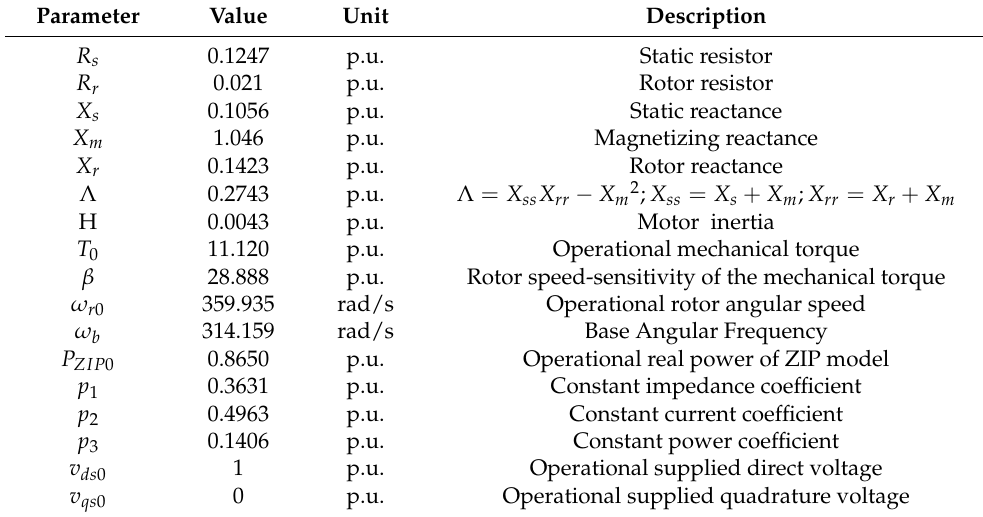
Table 2. Composite load model parameters. Reproduced from [18], IEEE: 2006. Parameter Value Unit